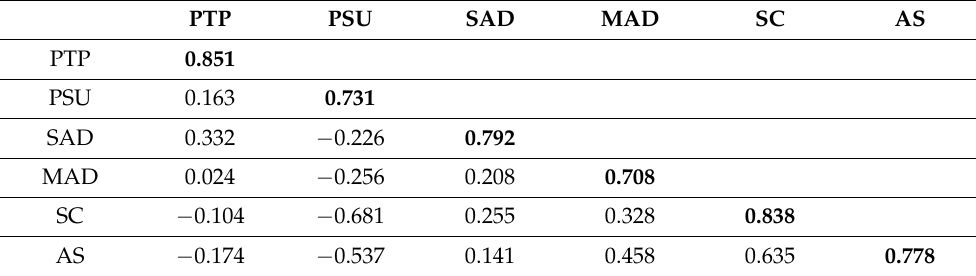
Table 4. Correlation between constructs (AVE and squared correlations).